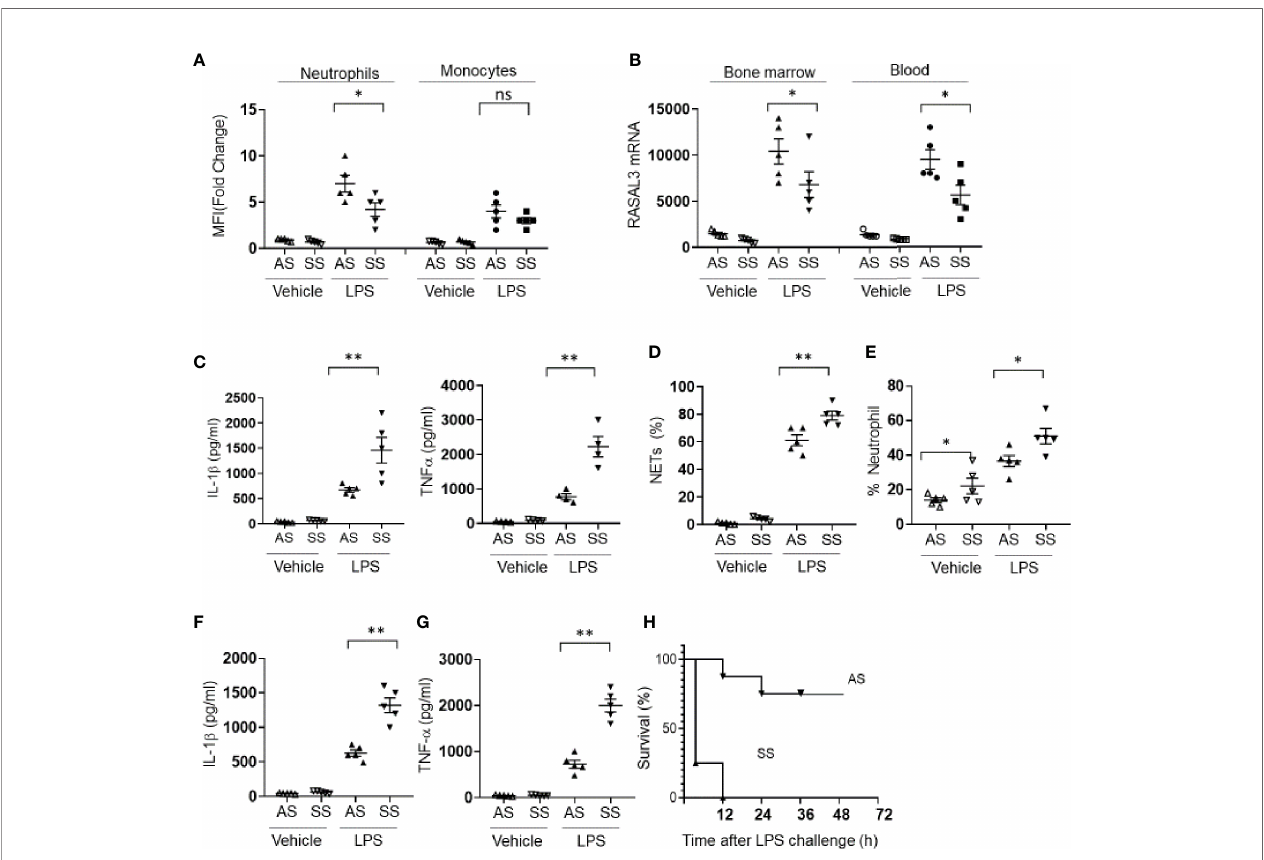
FIGURE 4 | RASAL3 de fi ciency drives hyperin fl ammation in sickle cell disease. (A) RASAL3 protein expression in BM neutrophils and monocytes from littermate sickle cell Townes (SS) and heterozygotes (AS). 3 h after LPS challenge, mice were sacri fi ced, and cells were obtained for analysis. Data are represented as fold change in mean fl uorescence intensity (MFI) relative to expression levels in unstimulated cells. (B) RASAL3 mRNA in bone marrow and circulating blood neutrophils of AS and SS at baseline, and 3 h after LPS challenge. (C) In fl ammatory cytokine production in neutrophils from AS and SS mice at baseline and after LPS challenge. Bone marrow isolated neutrophils were incubated with vehicle control or LPS at 37°C for 24 h. The production of IL-1 b , TNF- a were detected by ELISA. (D) NET production was determined by fl ow cytometric assessment for SYTOXRed+DAPI+ neutrophils after LPS or vehicle challenge. (E) Proportion of neutrophils in the circulation of AS and SS at baseline and after i.p. LPS injection (6 h). (F, G) In fl ammatory cytokine production in vivo by AS and SS mice upon challenge with LPS. IL-1 b (F) and TNF- a (G) levels in the blood were measured by ELISA. (H) Kaplan-Meier survival curve of AS and SS after LPS challenge in vivo (n=10 per group). Except H, data are shown as the mean ± SEM. Each symbol represents one mouse. Each experiment was performed at least two independent times. * p < 0.05 and ** p < 0.01. NS, not signi fi